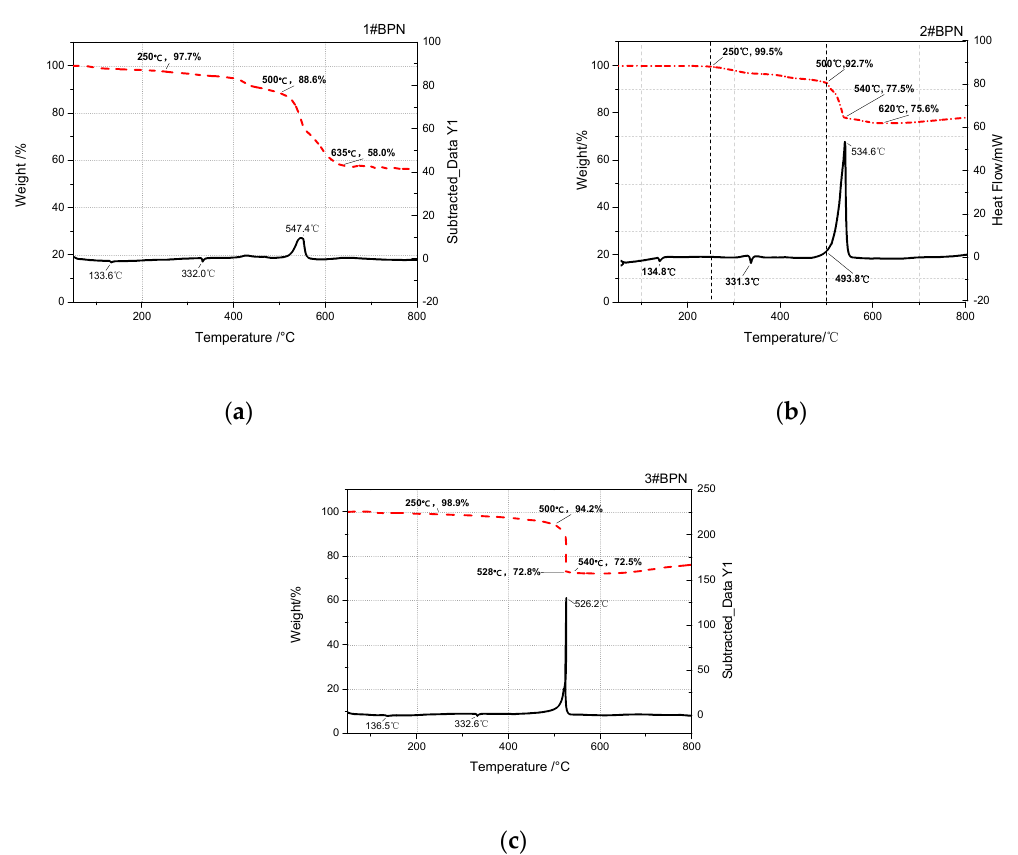
Figure 3. ( a ) TG–DSC curve of 1#BPN (15:85); ( b ) TG–DSC curve of 2#BPN (25:75); ( c ) TG–DSC curve of 3#BPN (33:67) (heating rate 5 °C/min).